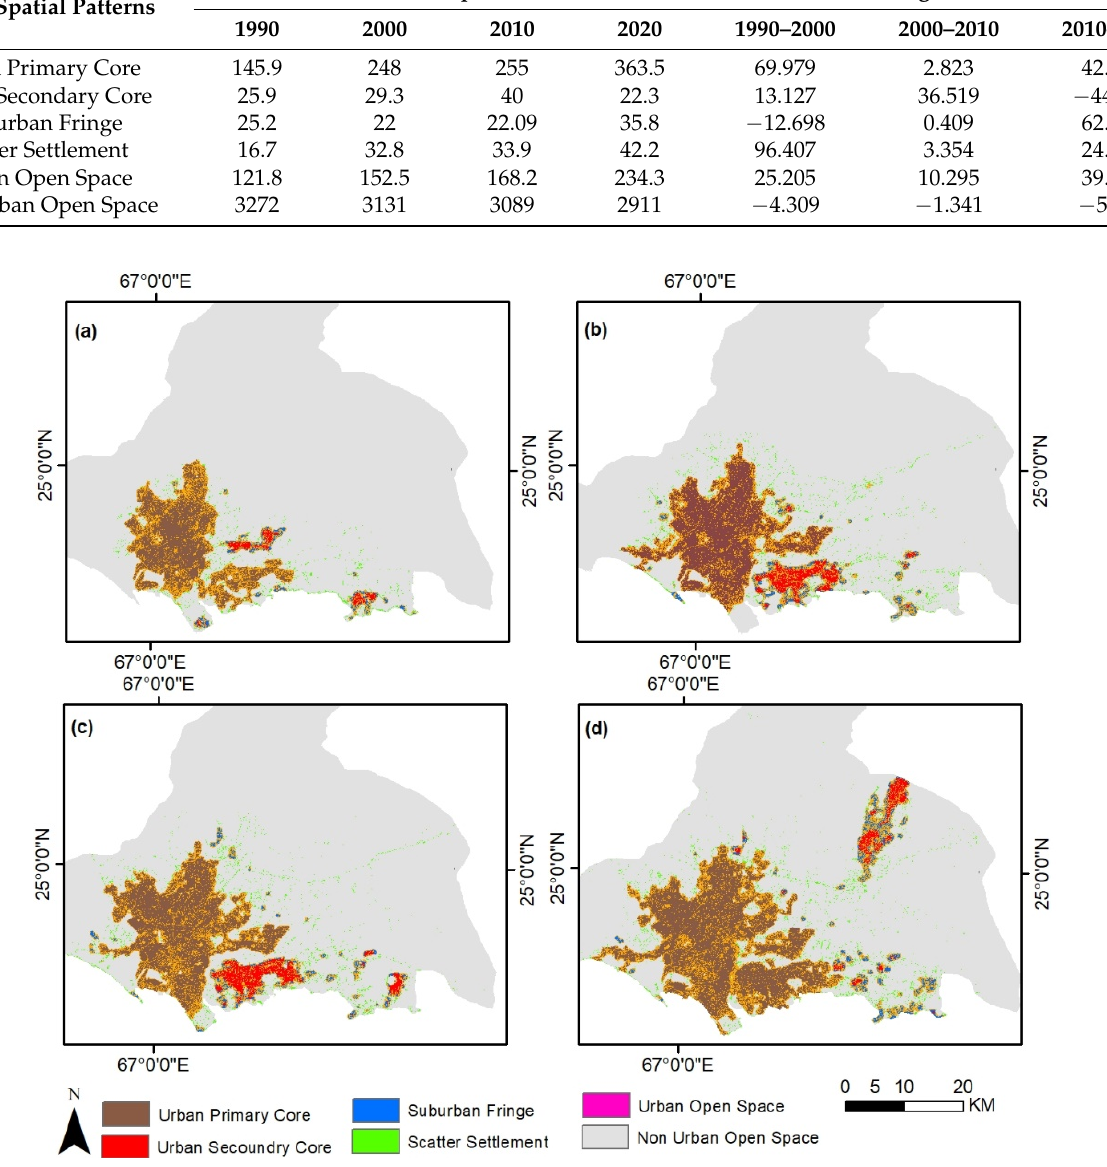
Figure 7. Urban landscape in Karachi in ( a ) 1990, ( b ) 2000, ( c ) 2010, and ( d ) 2020. The area of the suburban fringe and scatter settlements showed a marginal increase (Table 6). The urban open space increased from 121.8 sq.km in 1990 to 243.3 ssq.km in 2020, which indicates an increase in green space under the urbanized area. Most of this increase was observed in the core of districts of East, Korangi, and Kiamari. A drastic decrease from 3272 sq.km in 1990 to 2911 sq.km in 2020 in the area of non-urban open space can also be observed. The changes in each urban spatial pattern class within districts were analyzed (Table Table 6. Urban landscape changes in Karachi during the periods of 1990–2000, 2000–2010, and 2010–